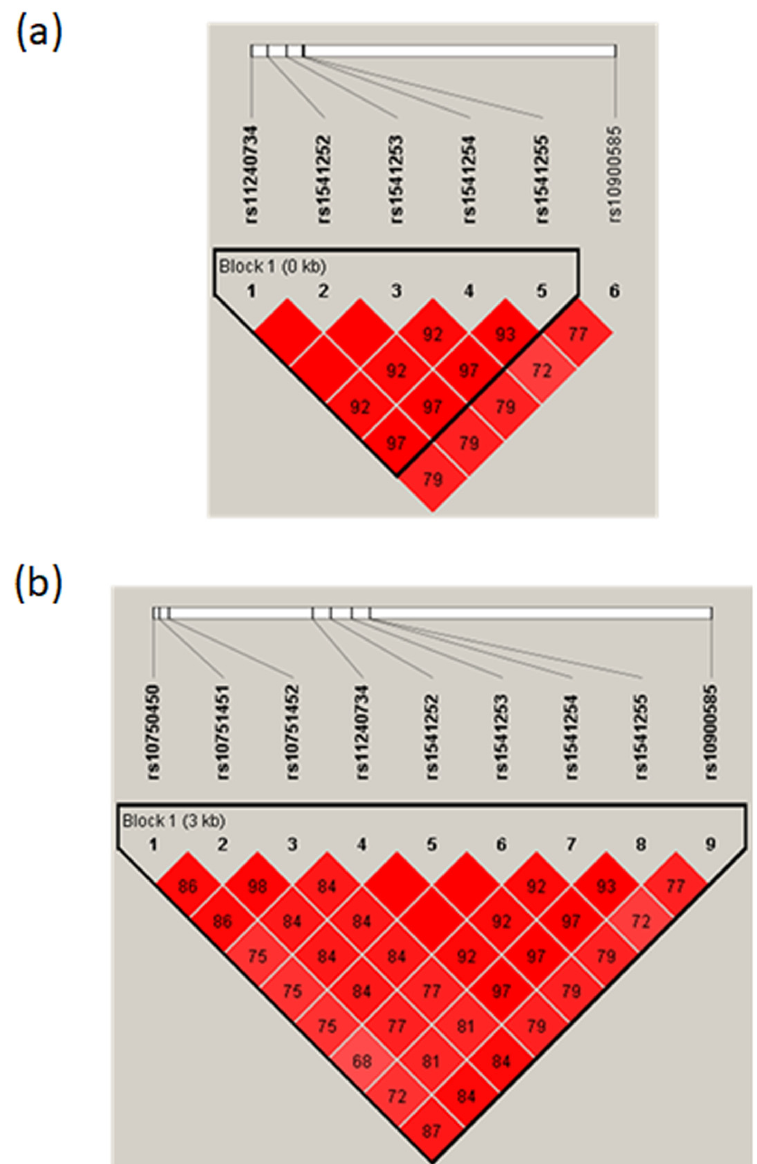
Figure 4. Linkage disequilibrium (LD) (r-squared) plot for the ATP2B4 variants in the Senegalese population. ( a ) LD between the candidate five SNPs and the tagSNP rs10900585 ( b ) LD between the eight candidate SNPs and the tagSNP rs10900585 displaying r 2 from 0.72–1. 2.4. Association of rs10751450, rs10751451, and rs10751452 with Severe Malaria